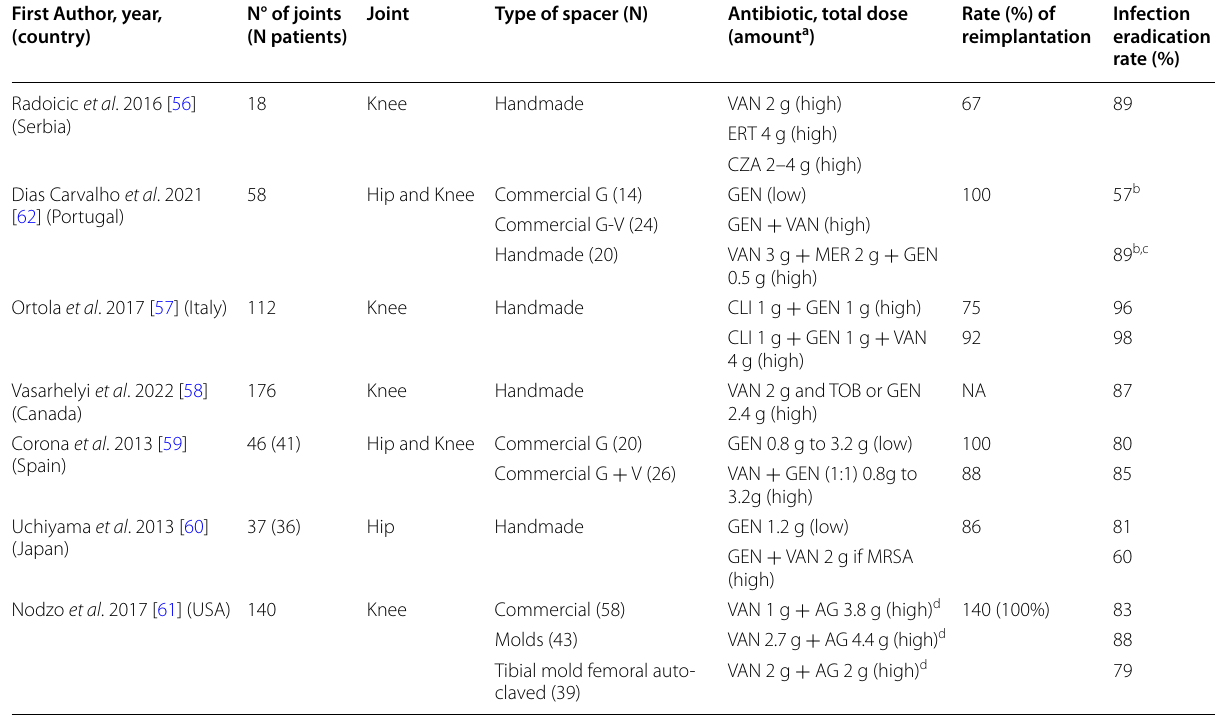
Table 2 Articles describing the infection eradication rate using antibiotic‑loaded spacers